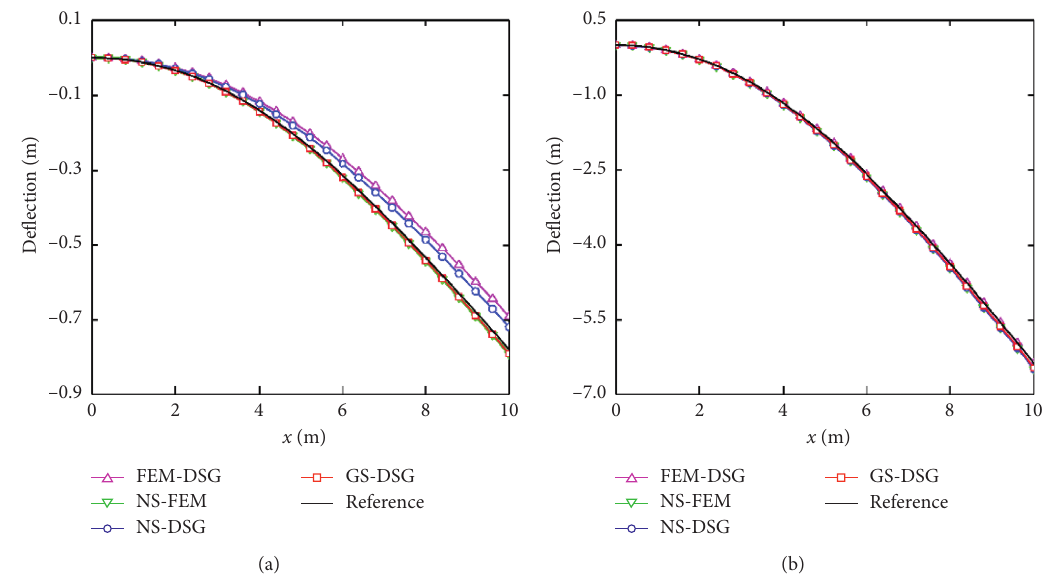
Figure 9: Deflections along the line OA with different thickness (concentrated load): (a) t � 0 . 01; (b) t � 0 .